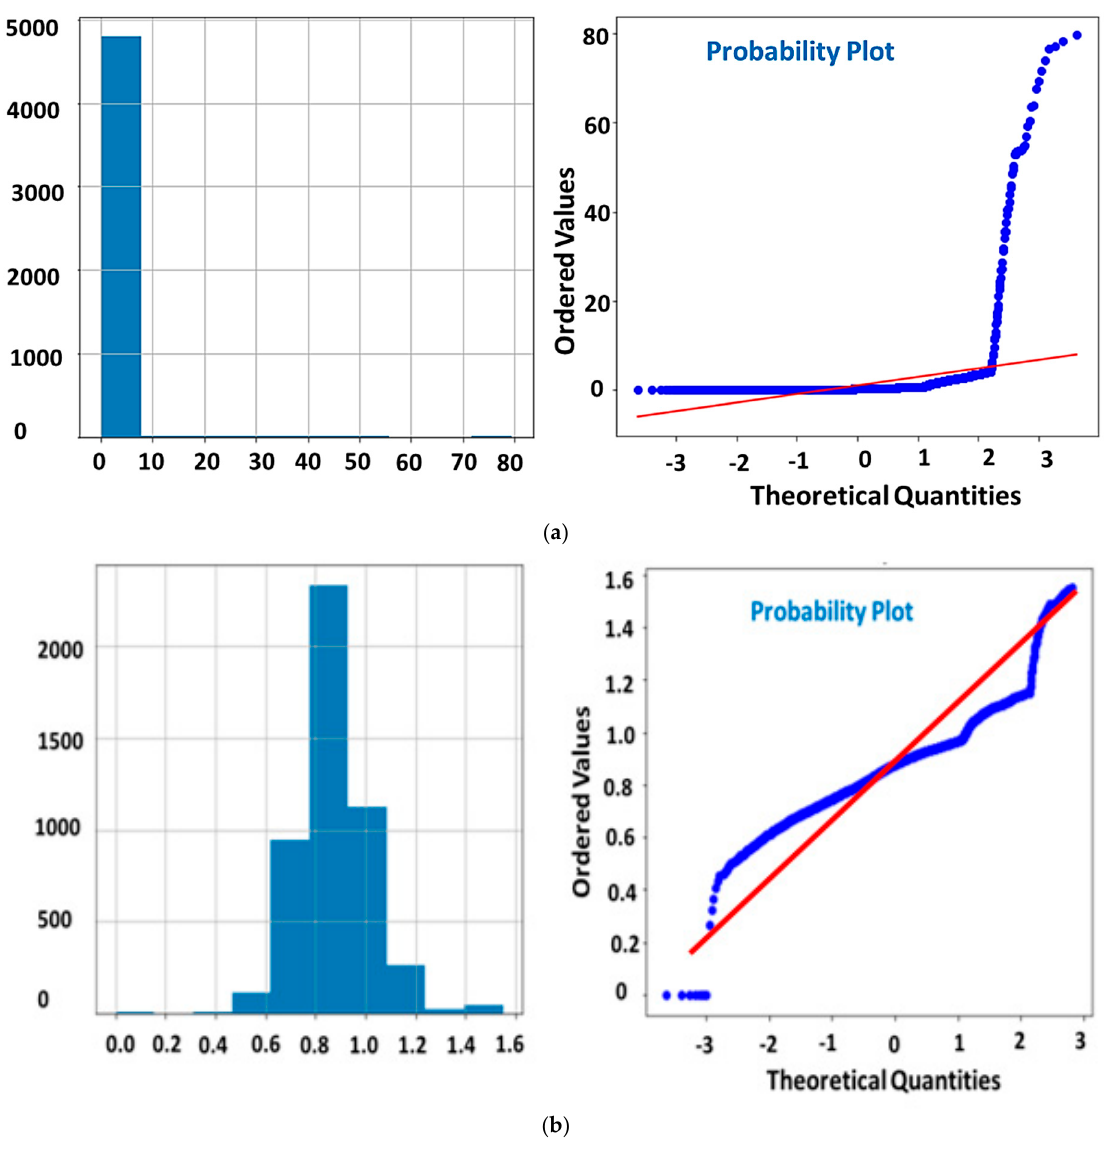
Figure 1. ( a ) Simple model data distribution and ( b ) data transformation with a robust scaler. Table 2. An overview of the employed methods to find the optimal deep learning model. S. No. Description Max R 2 Bayesian Surrogate Model 0.85 Forest, Gaussian Process, GBRT 0.94